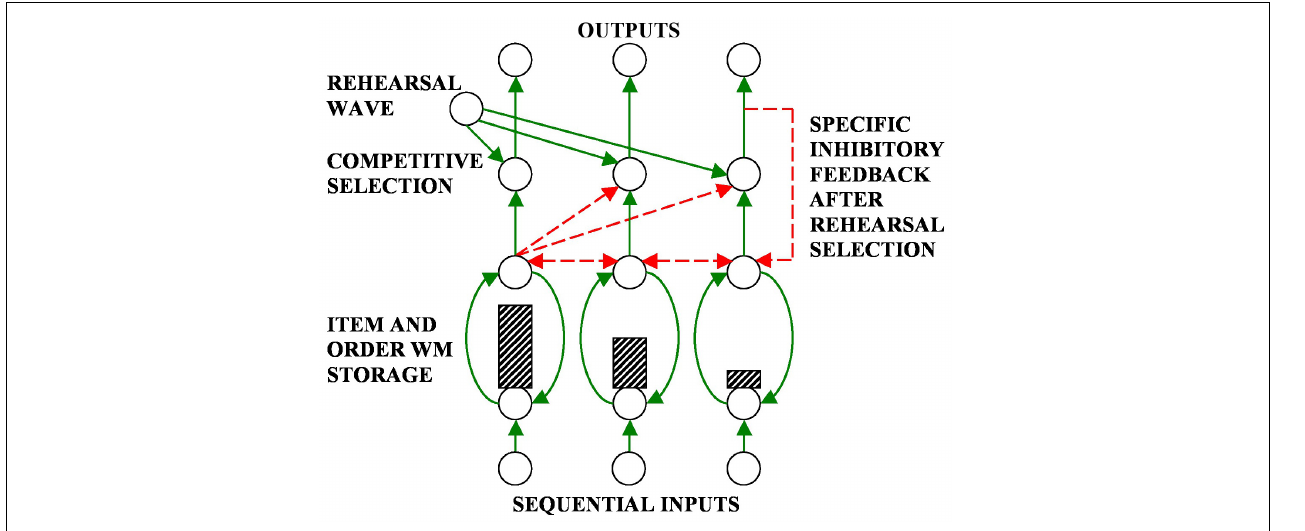
FIGURE 5 | An Item-and-Order working memory is defined by a recurrent on-center off-surround network whose cells obey the membrane equations of neurophysiology, also called shunting laws (Hodgkin and Huxley, 1952; Hodgkin, 1964; Grossberg, 1973, 1980a; Carpenter, 1977a,b, 1979). Excitatory connections are in green. Inhibitory connections are in red. A primacy gradient of activity is stored in working memory in this figure (dashed rectangles denote relative cell activities). Two simultaneously converging inputs are needed to fire a competitive selection cell. One input is a specific input from the corresponding working memory cell. The other input is a nonspecific input called a rehearsal wave. The working memory cell with the largest activity can fire the corresponding competitive selection cell when a rehearsal wave is on. Its output signal also activates a specific inhibitory feedback signal that shuts the competitive selection cell off, and thus allows the next most active working memory cell to be rehearsed next. Competitive selection cells are called polyvalent cells in the subsequent exposition. [Adapted from Grossberg (2013a)].